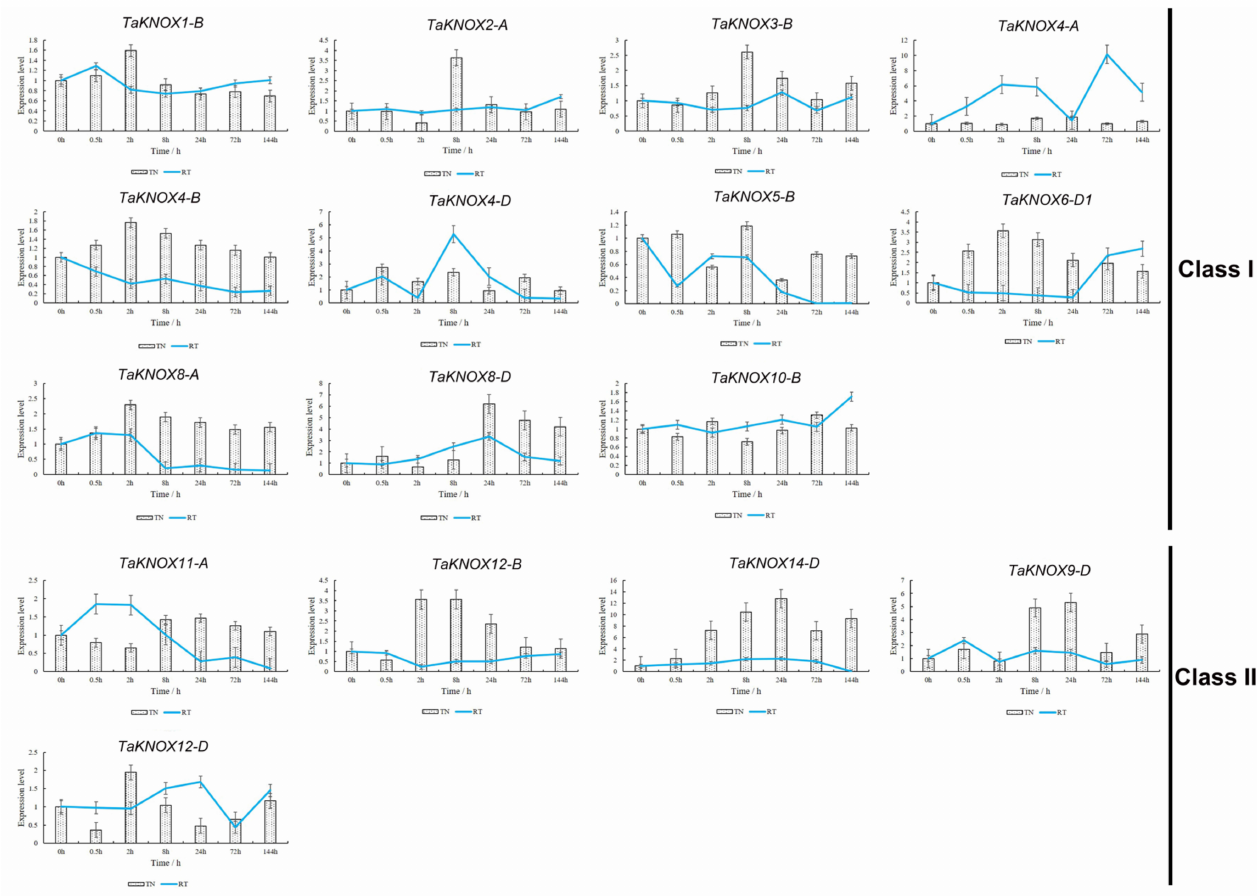
Figure 7. Expression patterns of 16 KNOX genes in response to mechanical treatment obtained by qRT-PCR. The actin gene is used as an internal control. The data shown are means ± SD obtained from three biological replicates. Histogram represents the TaKNOX genes expression pattern in wheat TN, line chart represents TaKNOX genes expression pattern in wheat RT. TN: tillering node; RT: root